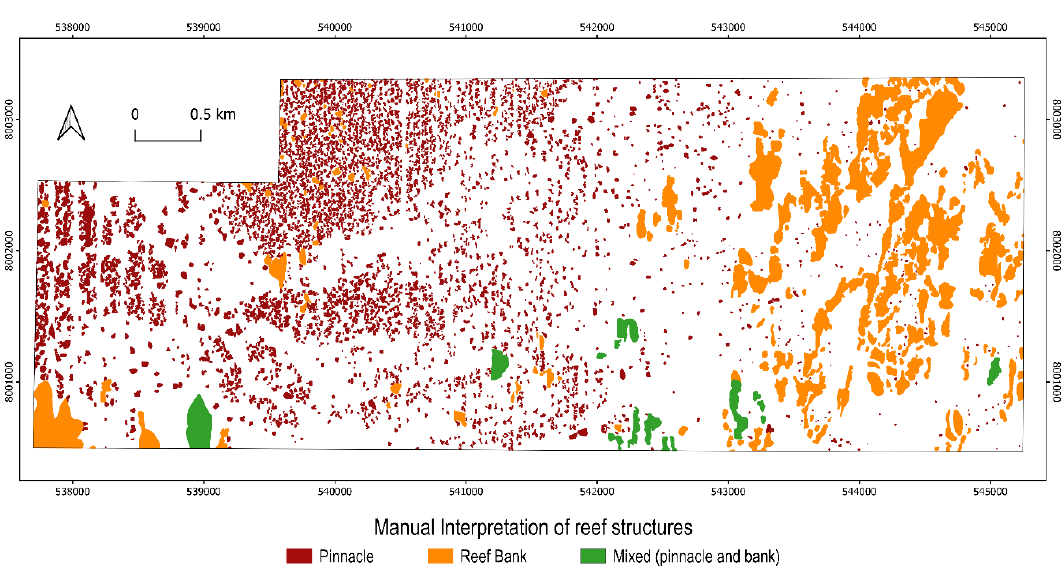
Figure 7. Map showing baseline map of reef distribution derived by manual interpretation.